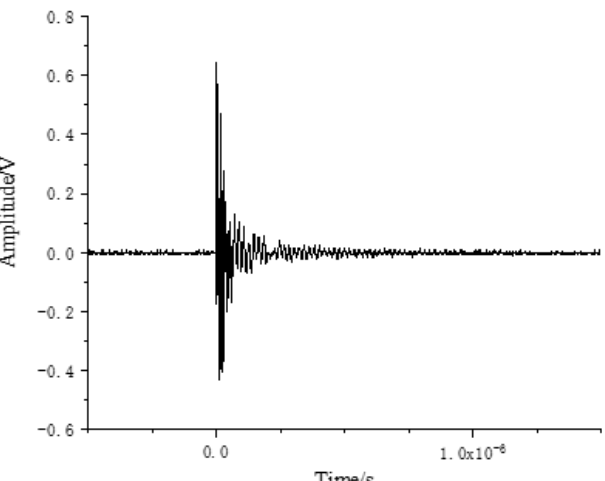
Figure 4. PD electromagnetic wave signal received by near - field probe .